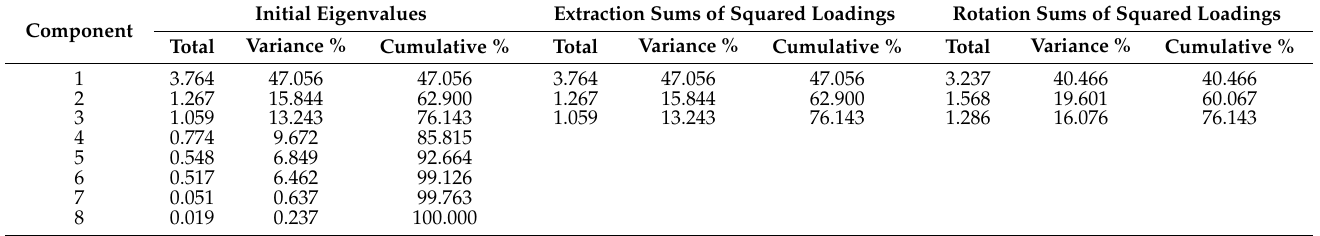
Table 12. Total variance